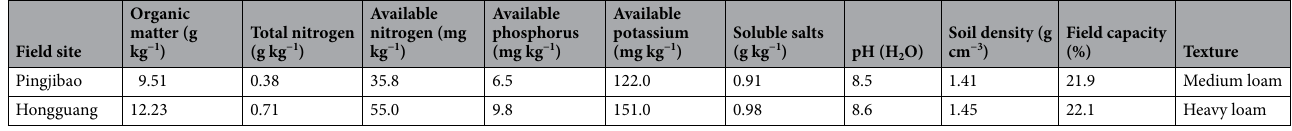
Table 1. Basic property of the tested soils in experiments (0–60